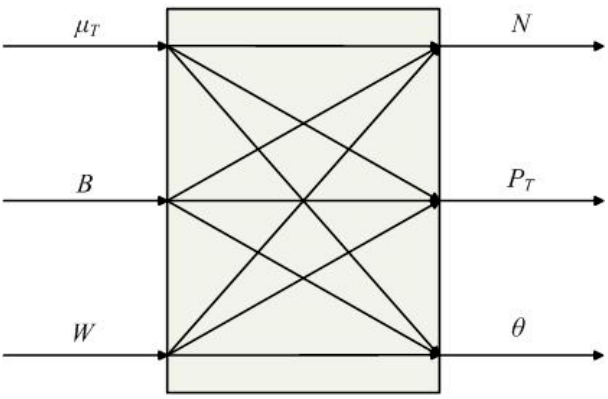
Figure 2. Coordinated control system (CCS) of a USC power plant.